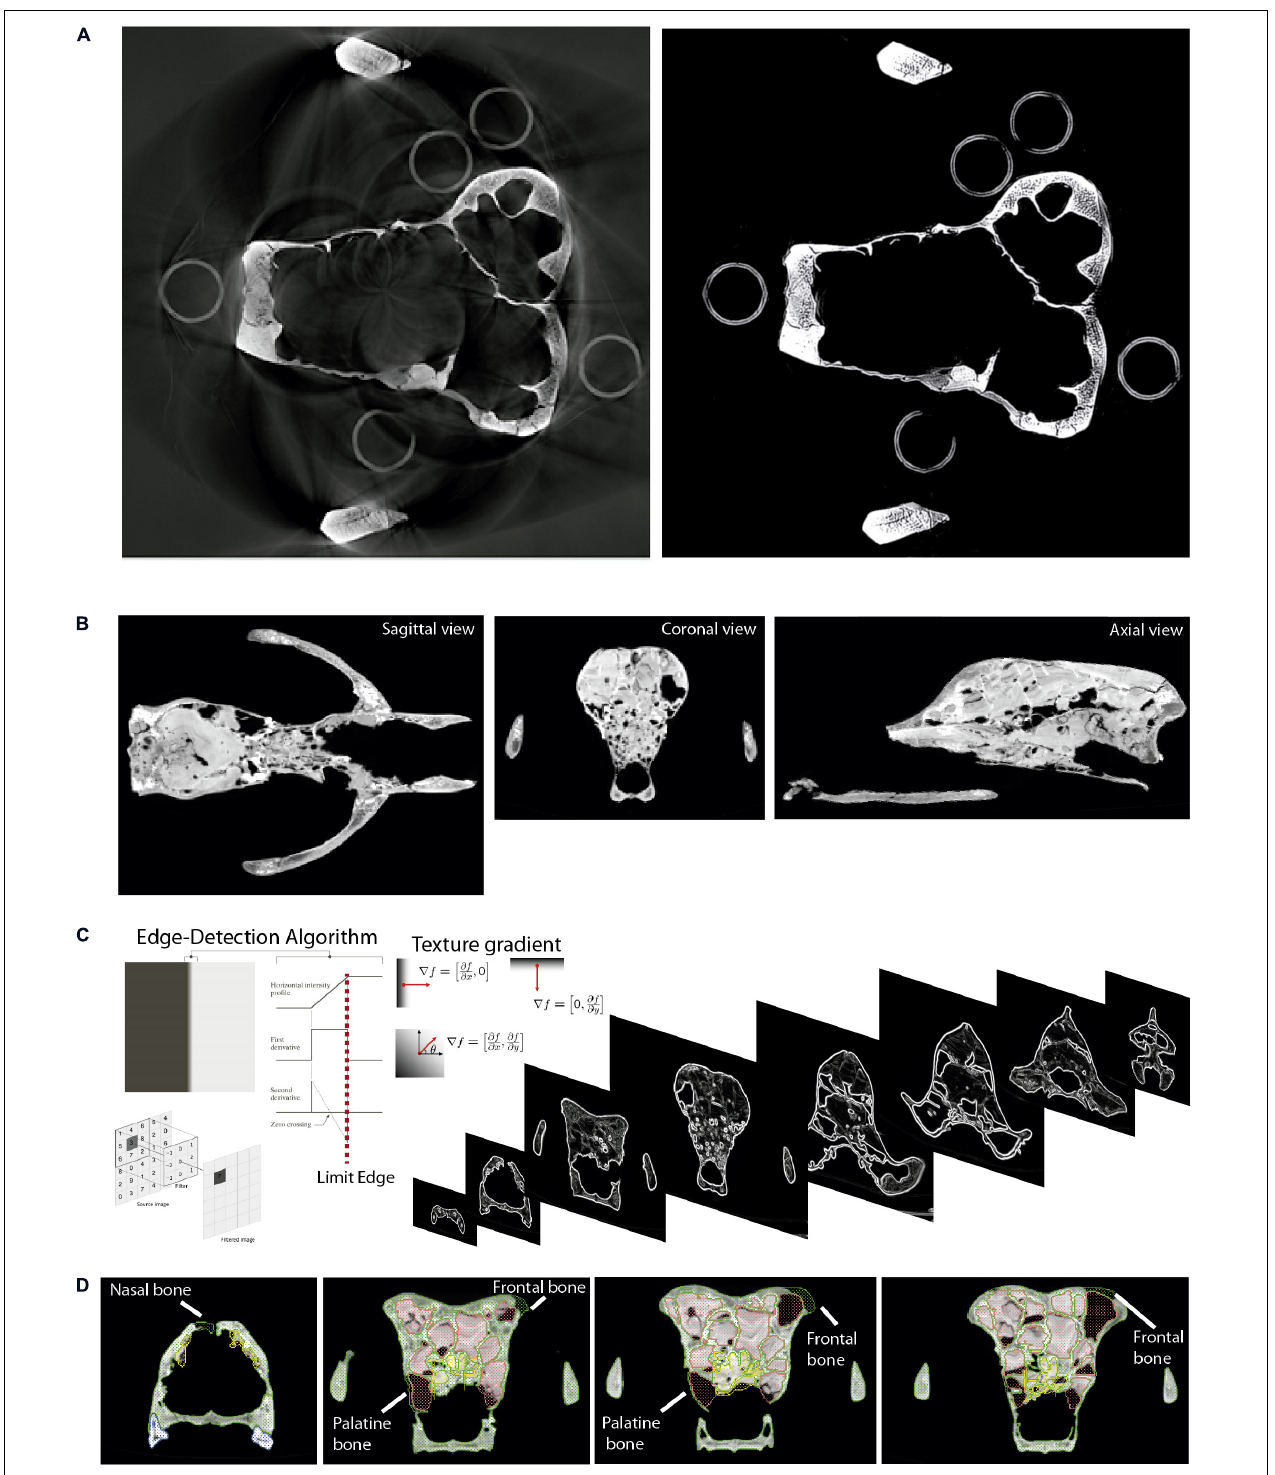
FIGURE 3 | Digital cleaning of the skull of Ursus spelaeus spp. as an example. (A) Removing artifact from the X µ CT, showing on the left the original image stack, and on the right the image without ring-shaped artifacts after applying the “mean” and “sharp” filters. (B) Sagittal, coronal, and axial views of the skull filled with exogenous material. (C) Edge-detection process applied to delimit the exogenous material from real bone (ref. image: Forsyth and Ponce, 2003; Gonzalez and Woods, 2008). (D) Coronal views of different slices along the anteroposterior axis, showing the bone delimited through the gradient filtering and the reconstructed parts (nasal, frontal, and palatine